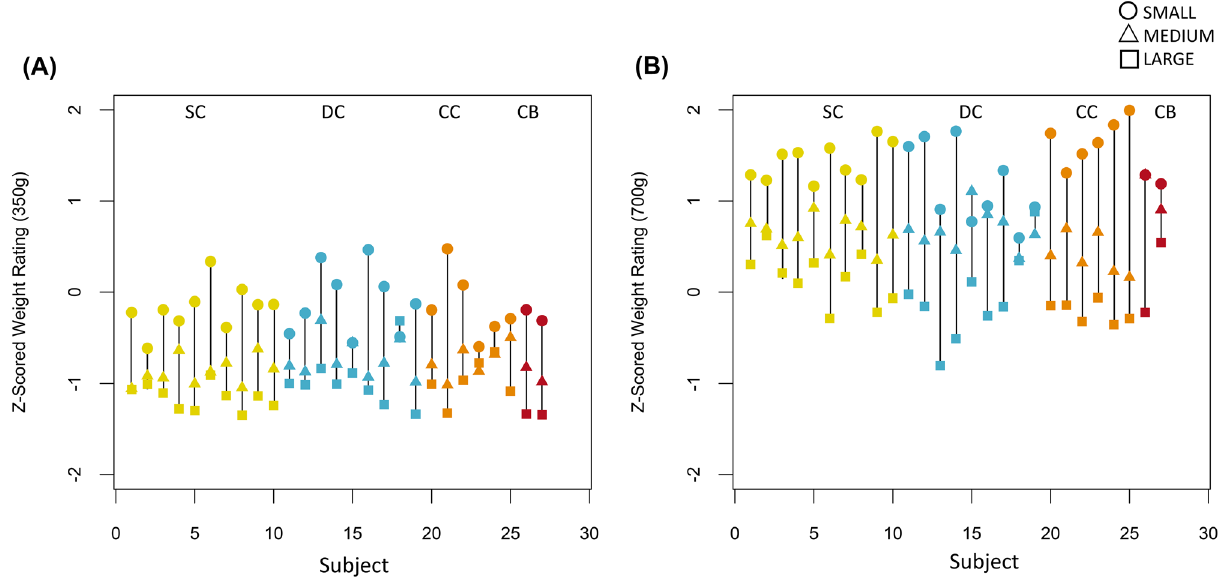
Figure 2. Experiment 1 (with visual and haptic size information); z-scored weight ratings of all individuals in the Sighted Control (SC, yellow), the Developmental Cataract group (DC, blue), the Congenital Cataract group (CC, orange), and two Congenitally Blind (CB, red) individuals, t ( A ) for the 350 g and ( B ) for 700 g weights (Experiment 1).